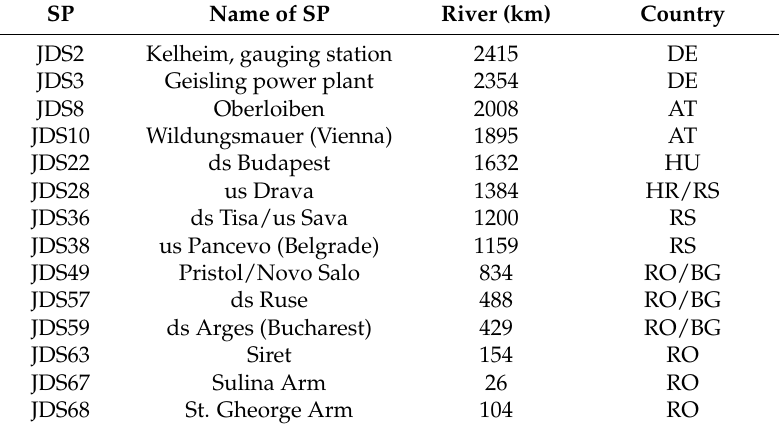
Table 1. JDS3 sampling sites chosen for isolation and their assignment to the upper-, middle-, or downstream stretches (SP = sampling point; us = upstream; ds = downstream). Country codes: Germany: DE; Austria: AT; Hungary: HU; Croatia: HR; Serbia: RS; Romania: RO; Bulgaria: BG. SP Name of SP River (km) Country JDS2 Kelheim, gauging station 2415 DE JDS3 Geisling power plant 2354 DE JDS8 Oberloiben 2008 AT JDS10 Wildungsmauer (Vienna) 1895 AT JDS22 ds Budapest 1632 HU JDS28 us Drava 1384 HR/RS JDS36 ds Tisa/us Sava 1200 RS JDS38 us Pancevo (Belgrade) 1159 RS JDS49 Pristol/Novo Salo 834 RO/BG JDS57 ds Ruse 488 RO/BG JDS59 ds Arges (Bucharest) 429 RO/BG JDS63 Siret 154 RO JDS67 Sulina Arm 26 RO JDS68 St. Gheorge Arm 104